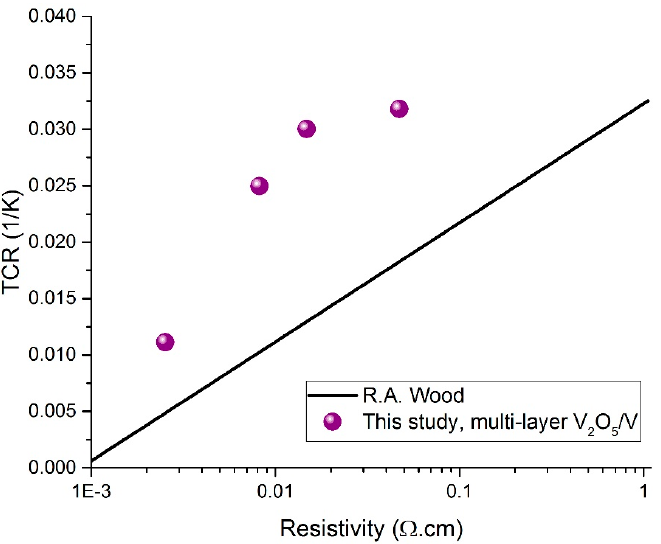
Figure 8. TCR versus resistivity for thermometer thin films developed in this work in comparison to the results published in